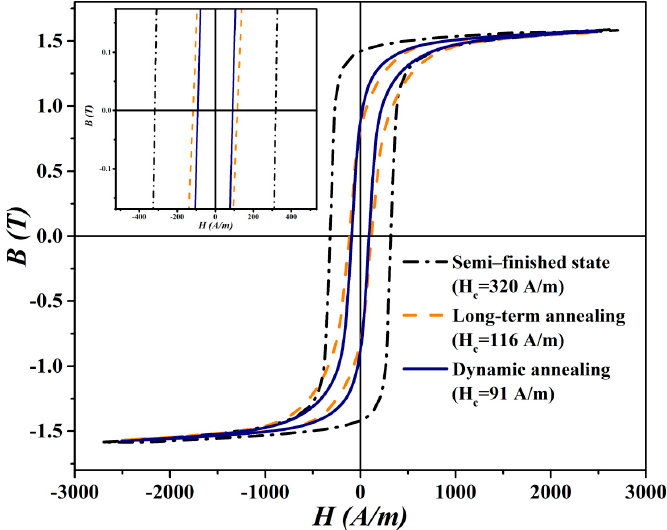
Figure 10. The measured B-H loops at 50Hz with peak flux densities at 1.7 T.